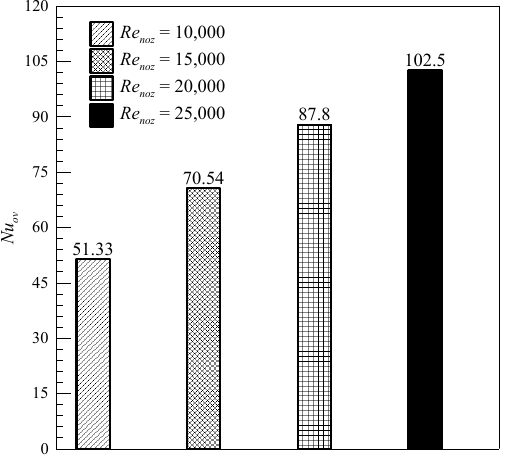
Figure 18. Overall Nusselt Number of the compound cooling unit at different Re noz .